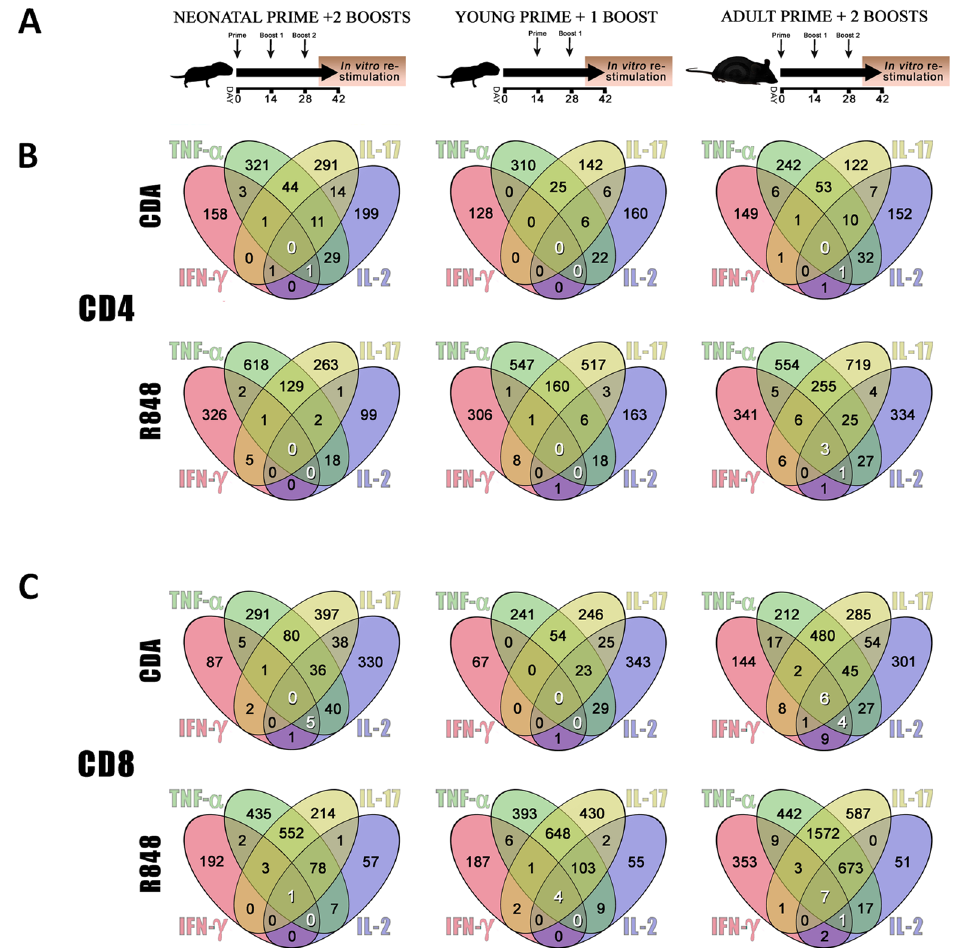
Figure 2. Mice antigen-specific cytokine responses to neonatal vaccination with different adjuvants. ( A ) Different vaccination strategies with ovalbumin (OVA) antigen and adjuvants (R848 and CDA). Neonatal mice received a prime (6–9 days old) followed by two boost doses (left diagram, neonatal prime + 2 boosts). Alternatively, the neonatal prime was skipped (center diagram, young prime + boost) or mice received the three doses as adult (right diagram, adult prime + 2 boosts). ( B ) Venn diagrams depicting the number of CD4 + T lymphocytes cytokine producers by million of cells measured by flow cytometry, after in vitro restimulation of splenocytes and surface and intracellular cytokine staining. Numbers in white are quadruple and triple cytokine producers regarded as indicators of maximal vaccine efficacy (i.e., producers of IL-2, IFN- γ , and TNF- α ). Treatments depicted in A) correspond to the diagrams in the column below, where it is R848 or CDA adjuvantation. ( C ) Venn diagrams depicting the number of CD8 + T lymphocytes positive for individual or multiple intracellular cytokine staining. White numbers are quadruple or triple cytokine producers by million of cells analyzed. Results are average of 3–5 mice per group.